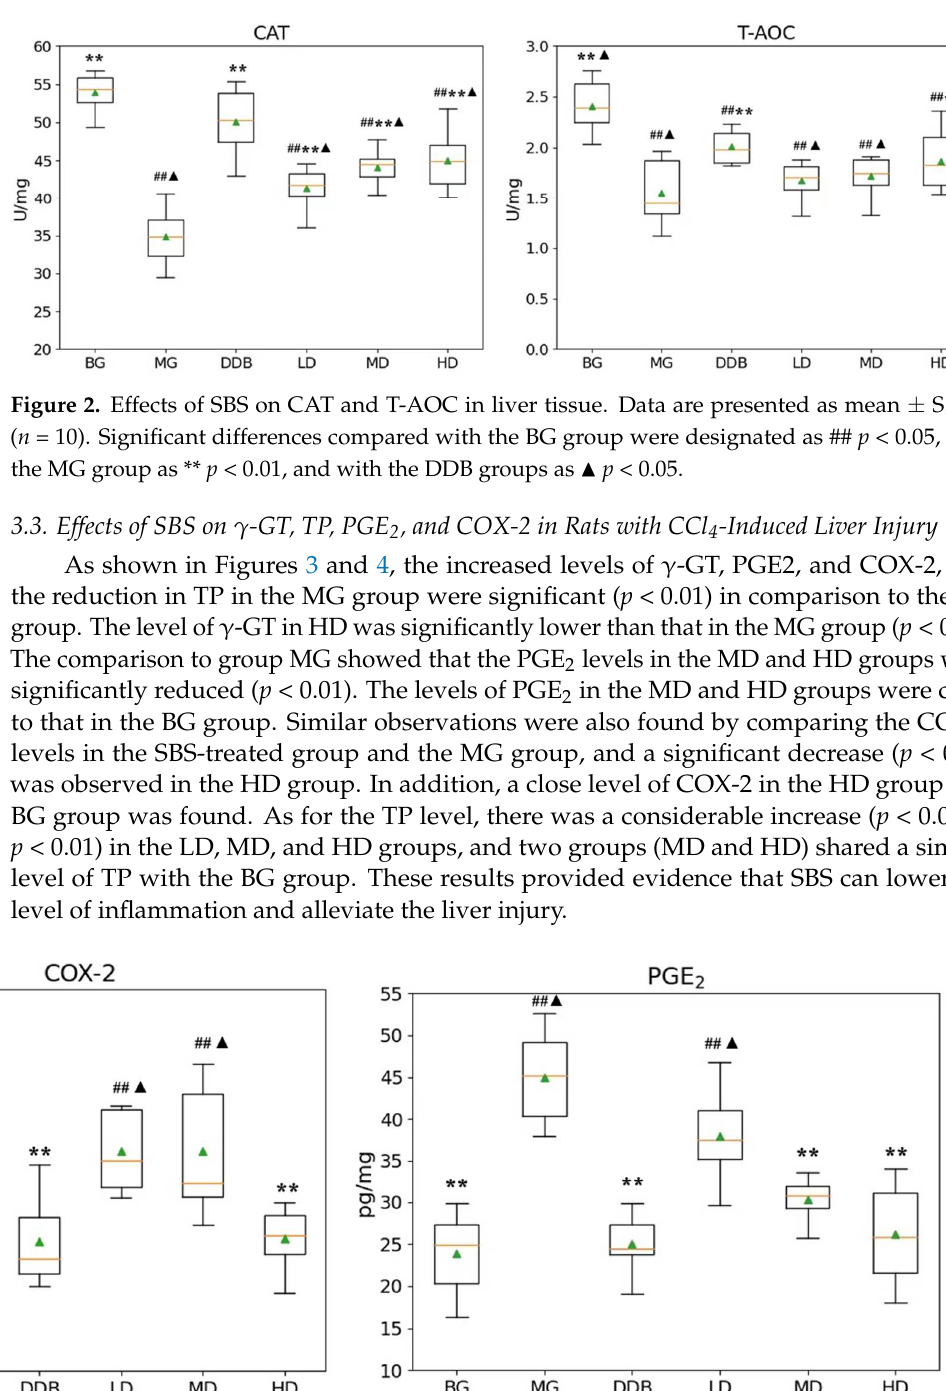
Figure 4. Effects of SBS on γ-GT and TP in liver tissue. Data are presented as mean ± S.E.M. ( n = 10). Significant differences compared with the BG group were designated as # p < 0.01 and ## p < 0.05, with the MG group as * p < 0.05 and ** p < 0.01, and with the DDB groups as ▲ p < 0.05. 3.4. Electron Microscopic Observations of Liver Tissue An important observation could be obtained based on Figure 5, where the structure of liver tissues of group BG was obvious and normal. However, the MG group showed a fuzzy liver structure and obvious damage (e.g., necrotic liver cells, a large number of swol- len mitochondria, many lipid droplets in the cytoplasm, and a large number of the ex- panded endoplasmic reticulum) was found. In the DDB group, the liver structure was partially clear, but some mitochondria were still slightly swollen and autophagic, and some liver cells were suspected to be necrotic. In addition, a small number of lipid drop- lets were formed. The liver structure of the LD and MD groups was clear, but there were still some rough expansions of endoplasmic reticulum and a small number of lipid drop- lets, as well as a few necrotic hepatocytes. The HD group had a relatively evident liver structure with abundant mitochondria in the cytoplasm, and the mitochondrial structure was basically obvious and clear. It was also found that necrotic hepatocytes and lipid droplets were greatly reduced.